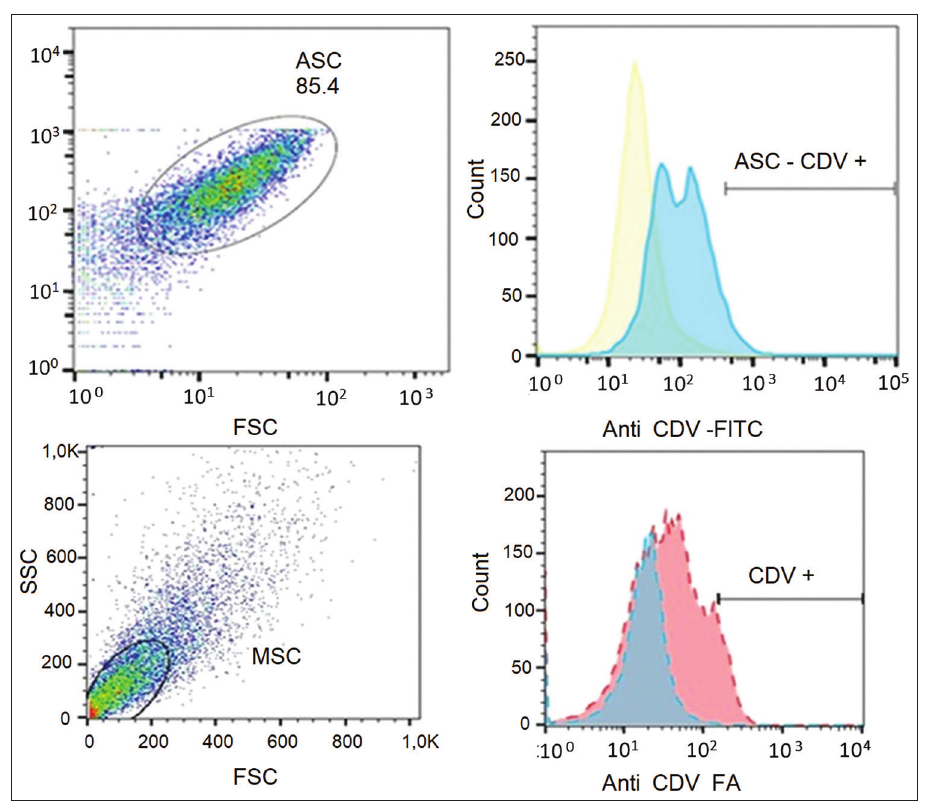
Figure-5: Flow cytometry. Selection protocol using stem cells from healthy subjects as a blank (blue curve) versus stem cells from sick subjects (red curve).